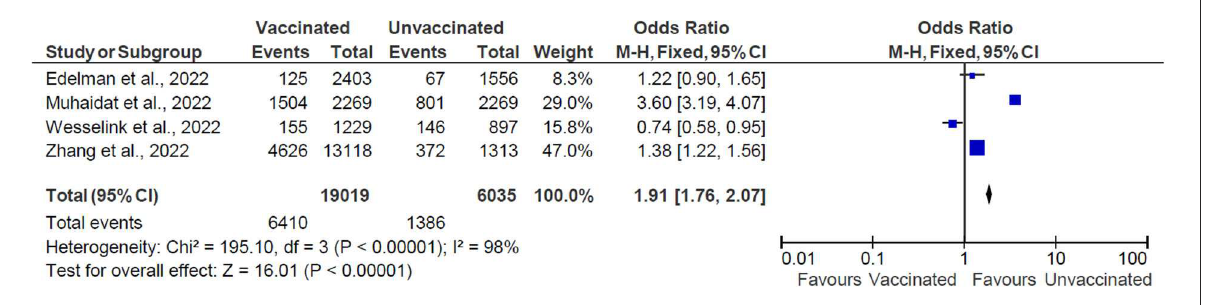
blood vessel maturation, leading to potential changes in menstrual blood loss and cycling (12,